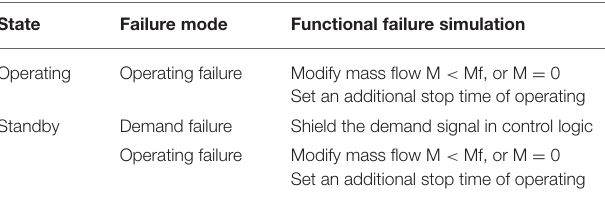
TABLE 1 | Mapping rules of functional failure simulation for CCS